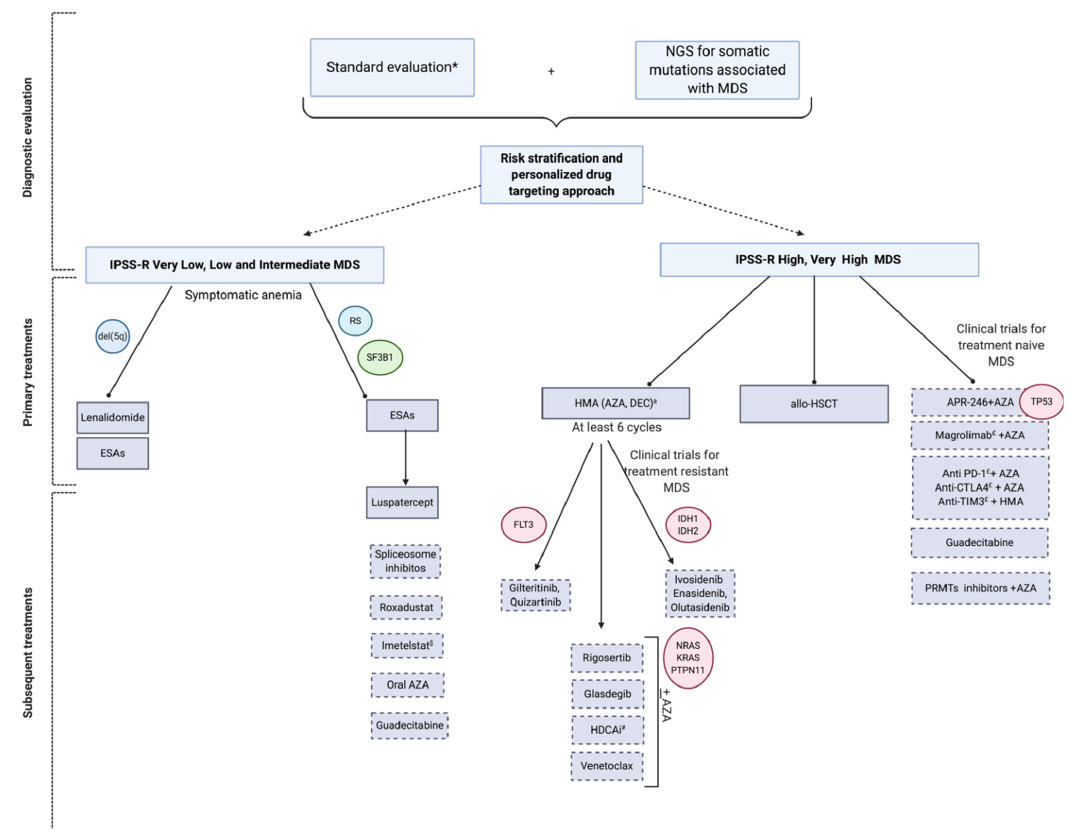
Figure 2. Precision management of MDS in the era of genomics and new tailored treatments. Diagnostic and therapeutic algorithm of patients with MDS according to individualized approaches taking into account the Revised International Prognostic Scoring System (IPSS-R) and genomic data in the choice of targeted treatments. * Standard evaluation includes: Complete blood count (CBC), examination of peripheral blood smear, basic chemistry panel, serological tests for CMV, EBV, HIV, viral hepatitis, PB19, haptoglobin, serum erythropoietin, folate, serum ferritin, iron, TIBC, TSH, LDH, PNH clone, bone marrow cytomorphology, cytogenetics, flow cytometry. a AZA is currently approved in U.S. for all MDS and in Europe for high risk MDS; DEC is approved in U.S. for high-risk MDS/AML and in Europe for AML. $ Hypothetical benefit of telomere length assessment # Hypothetical benefit for gene testing and histone acetyltransferases. Abbreviations: MDS: Myelodysplastic syndromes, RS: Ring sideroblasts, TF: Transfusion, HDAC(i): Histone deacetylases (inhibitor); AZA: Azacitidine; DEC: Decitabine; PRMTs: Protein arginine methyltransferases; and allo-HSCT: Allogeneic stem